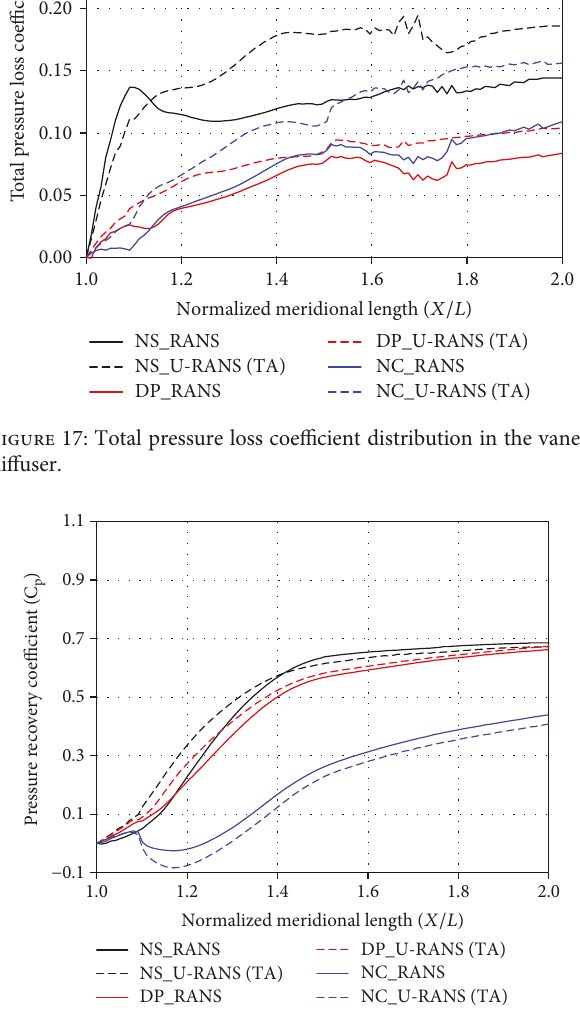
Figure 18: Static pressure recovery coe ffi cient distribution in the vaned di ff user.